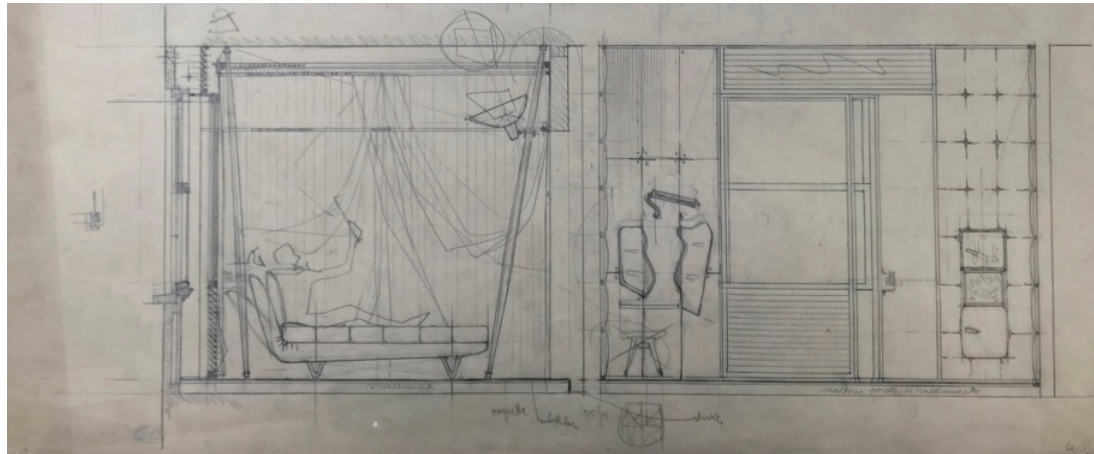
Figure 3. ACM P.9C.92.5: Section drawings with figure on the bed, operating the